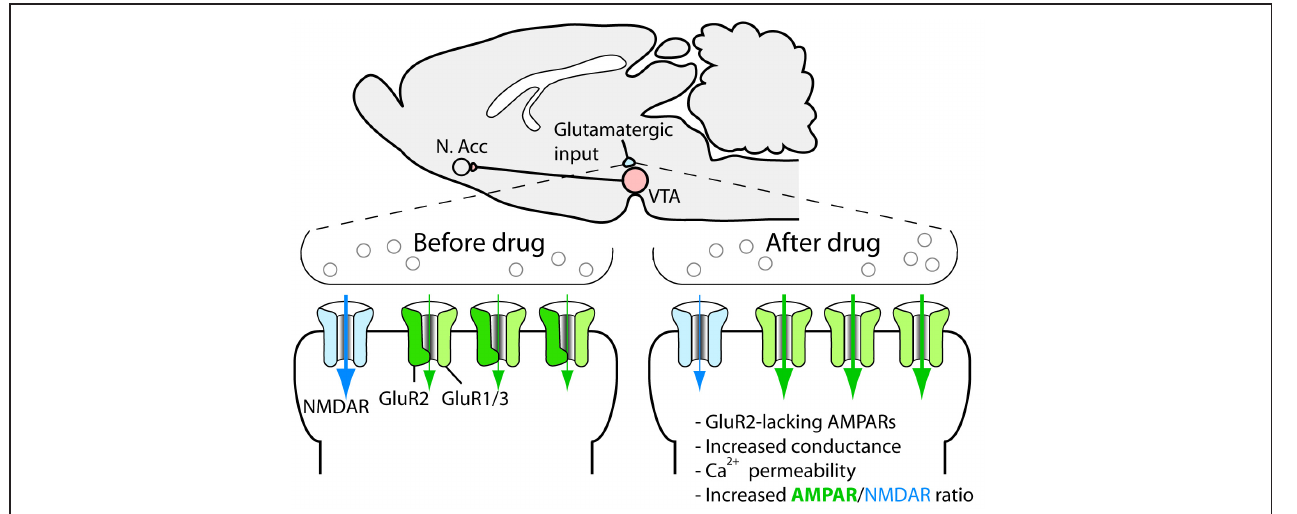
FIGURE 3 | Drug-induced synaptic strengthening of excitatory synapses on dopaminergic